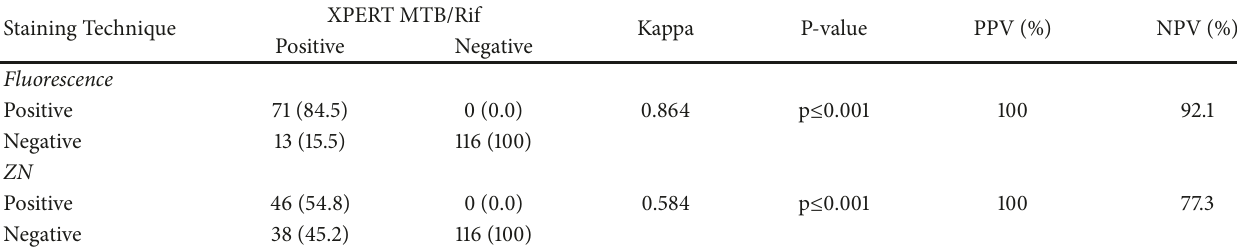
Table 2: Correlation of fluorescence and ZN staining techniques with Xpert MTB/Rif. Staining Technique